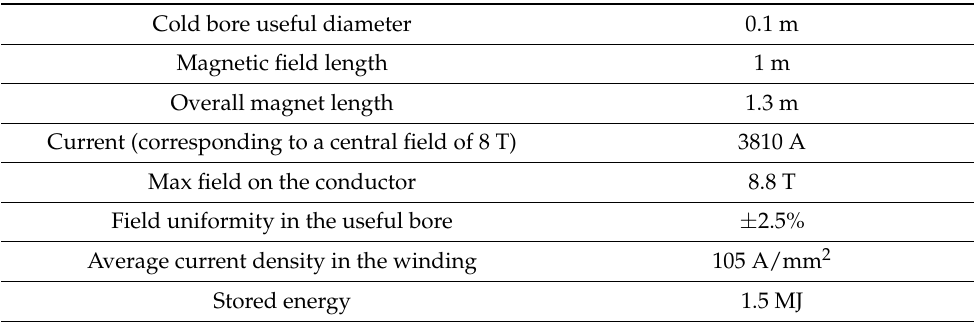
Table 2. Main characteristics of the PVLAS-LNL magnet built at CERN by Mario Morpurgo as a prototype for the original D2 CERN proposal to measure